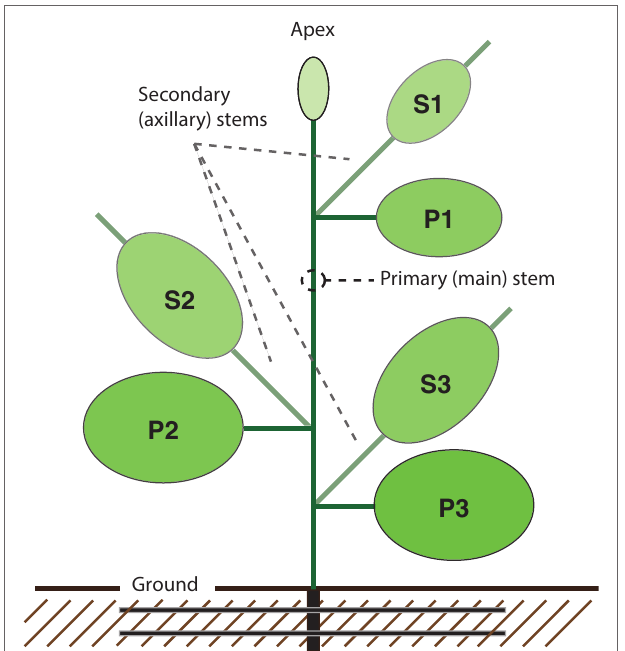
FIGURE 1 | Schematic overview of the N. benthamiana protein factory. The plant is composed of six “leaf production units,” each regrouping leaves of similar physiological age. P units regroup top (young) leaves (P1), middle (mature) leaves (P2), and bottom (older) leaves (P3) of the main (primary) stem. S units regroup axillary (secondary) stems and leaves emerged from P1 leaves (S1), P2 leaves (S2), and P3 leaves (S3). Main stem apex (Apex) includes the main stem apical bud and small leaves appeared after agroinfiltration during the protein expression period.